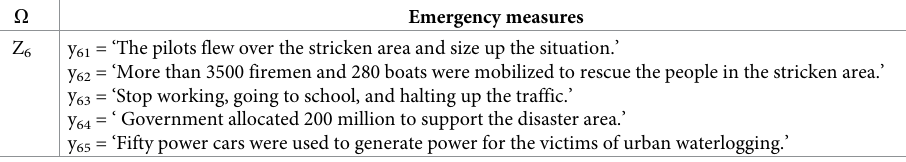
Table 6. Emergency measures of the similar historical